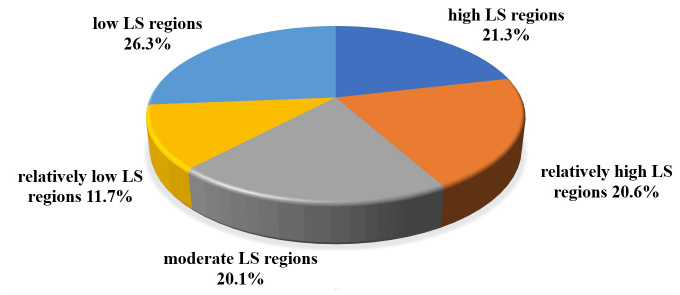
Figure 9. The proportion of the area of regions of each LS level to the total area of southern Anhui.